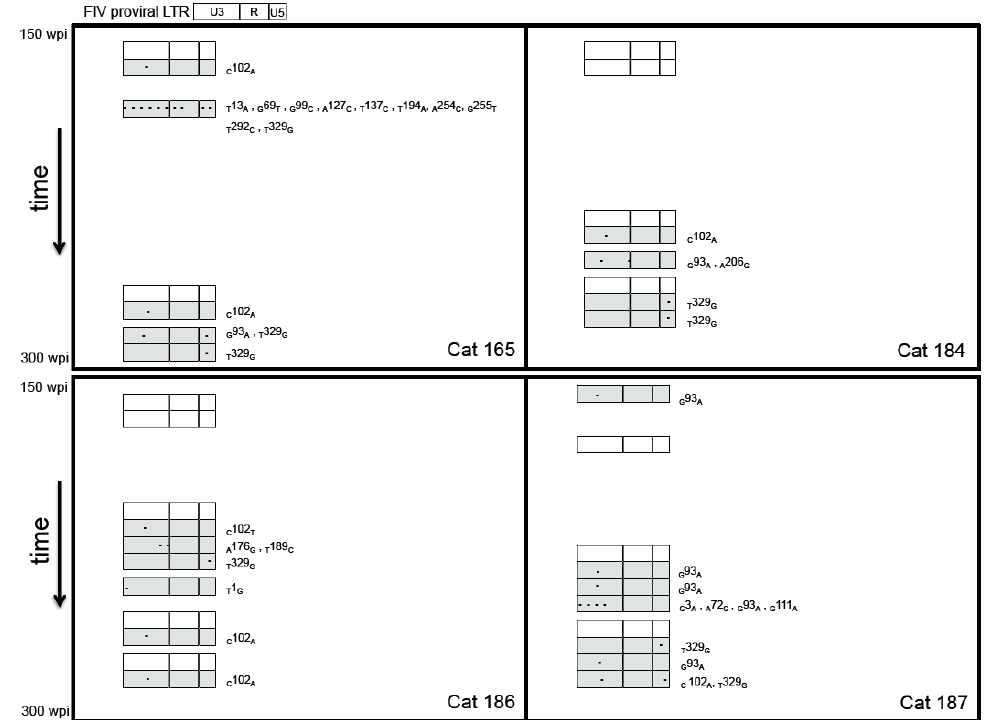
Figure 2. Serial analysis of amplified, cloned, and sequenced FIV proviral LTR segments from PBMCs of four FIV-infected cats over time during the asymptomatic phase (150–300 wpi). Each rectangle represents the FIV proviral LTR divided into the U3, R and U5 regions. Shaded rectangles indicate that the LTR sequence differed from the wild-type inoculating virus. Proviruses with point mutations were more commonly amplified than wild type (non-shaded rectangles). The approximate position of the SNP is denoted by an asterisk in U3, R, or U5 regions, with exact position and substituted base stated to the right of the shaded rectangle. Each rectangle represents a sequence derived from a single clone.